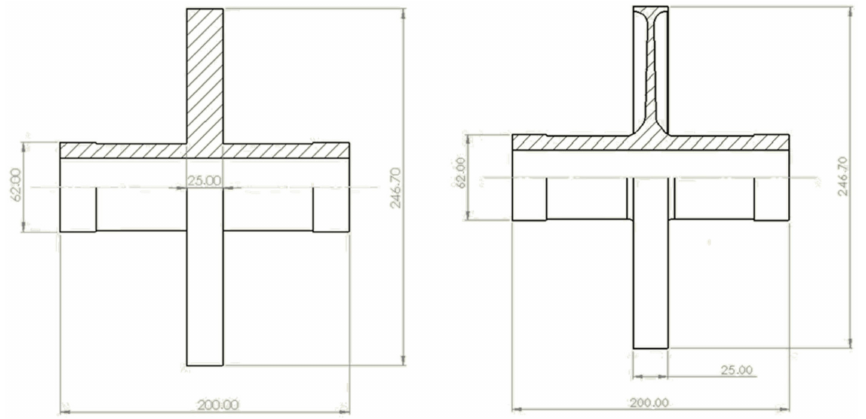
Figure 4. Drawing of the driven gear: on the left solid geometry, on the right flexible web